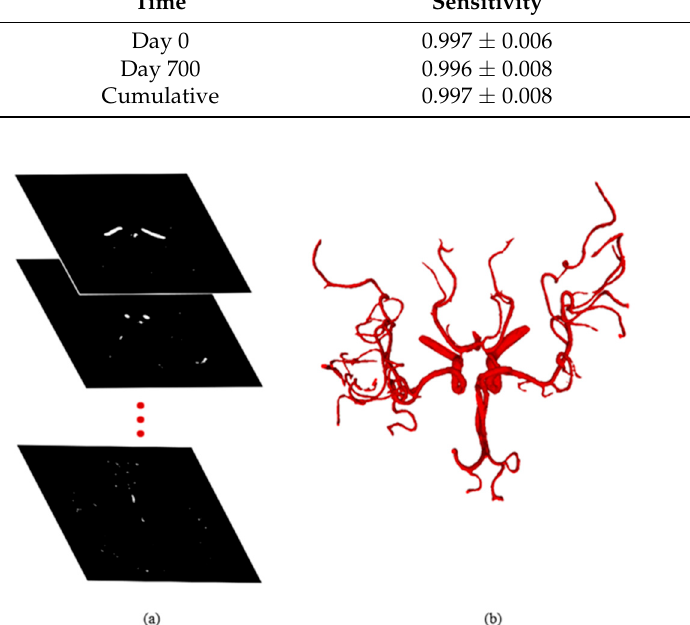
Figure 4. Example of segmentation algorithm output. ( a ) Sample image slices of a patient at day 0. ( b ) Sample 3D reconstruction of the segmented cerebrovascular system using a growing tree model.